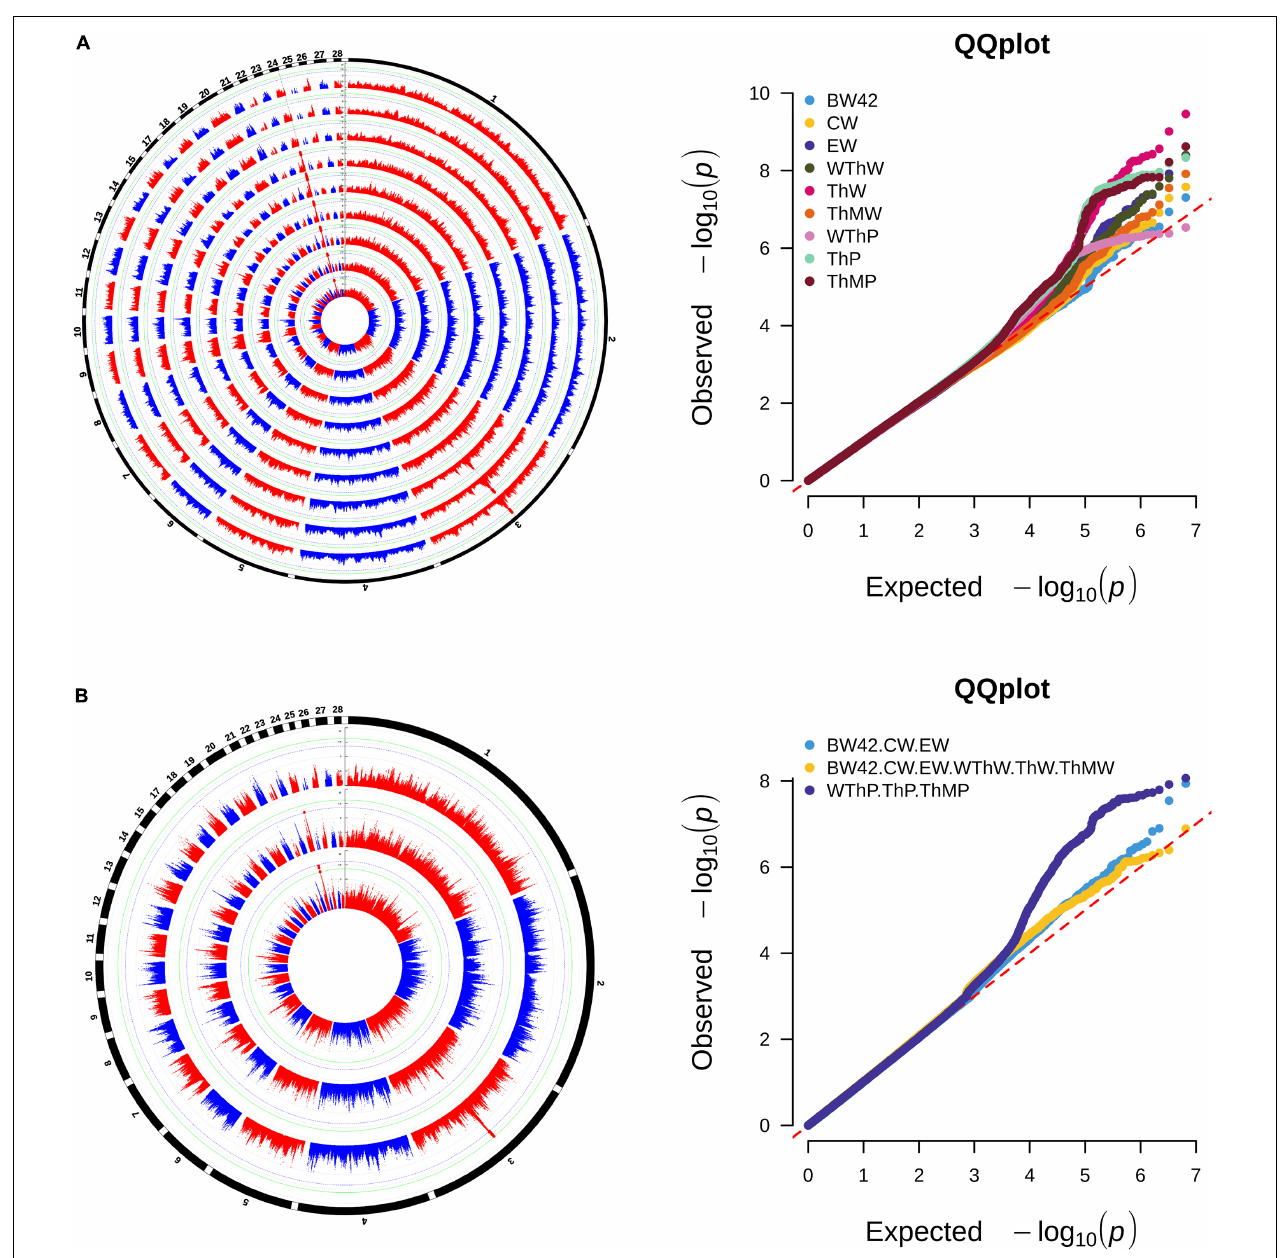
FIGURE 2 | Manhattan and quantile-quantile plots of univariate GWAS (A) and multivariate GWAS (B) for carcass traits. Each dot represents an SNP in the dataset. The circle Manhattan plots from the inside to the outside are BW42, CW, EW, WThW, ThW, ThMW, WThP, ThP, and ThMP. The horizontal blue and green lines indicate the thresholds for genome-wide significance ( P -value = 7.64e-9) and suggestive significance ( P -value = 1.53e-7),